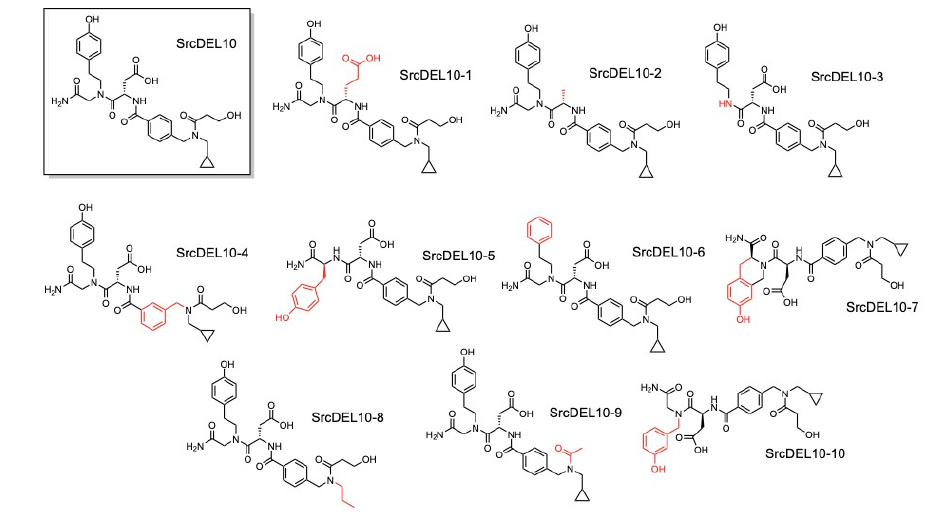
Figure 4. Synthesized derivatives of SrcDEL10 .